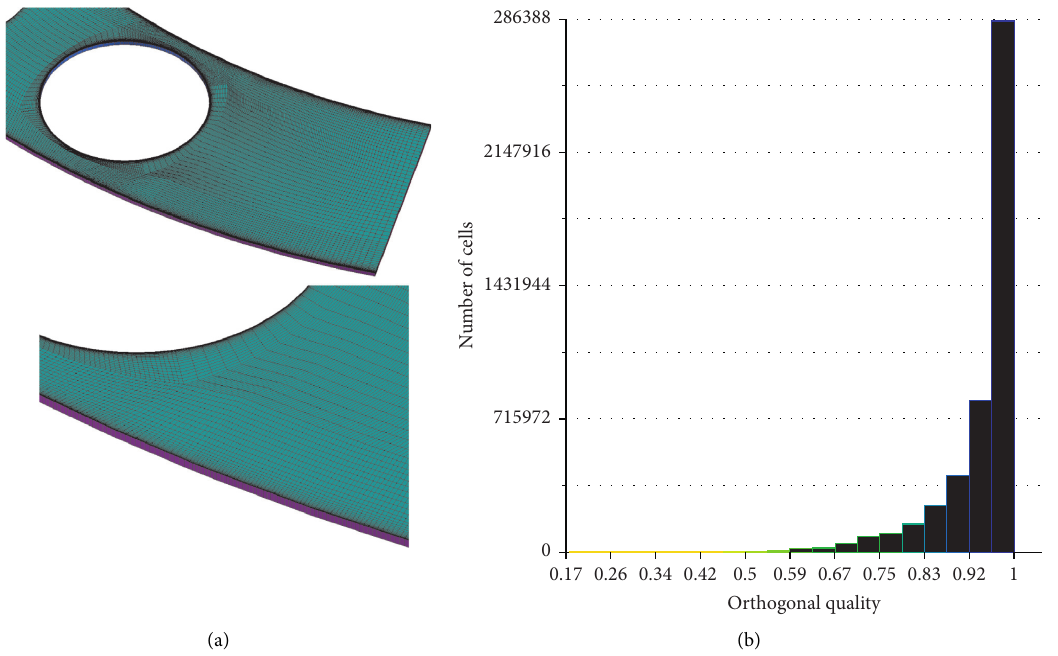
Figure 13: Mesh and quality. (a) Mesh internal detail and (b) orthogonal quality.